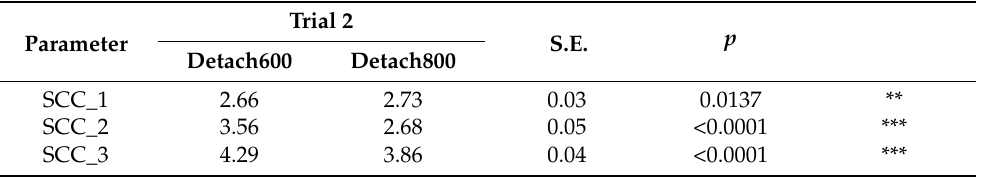
Table 4. Least-square means (LSM), standard error (S.E.), and statistical difference ( p -value) of the somatic cells count in the 3 measurements (1–3) in chronological order for Trial